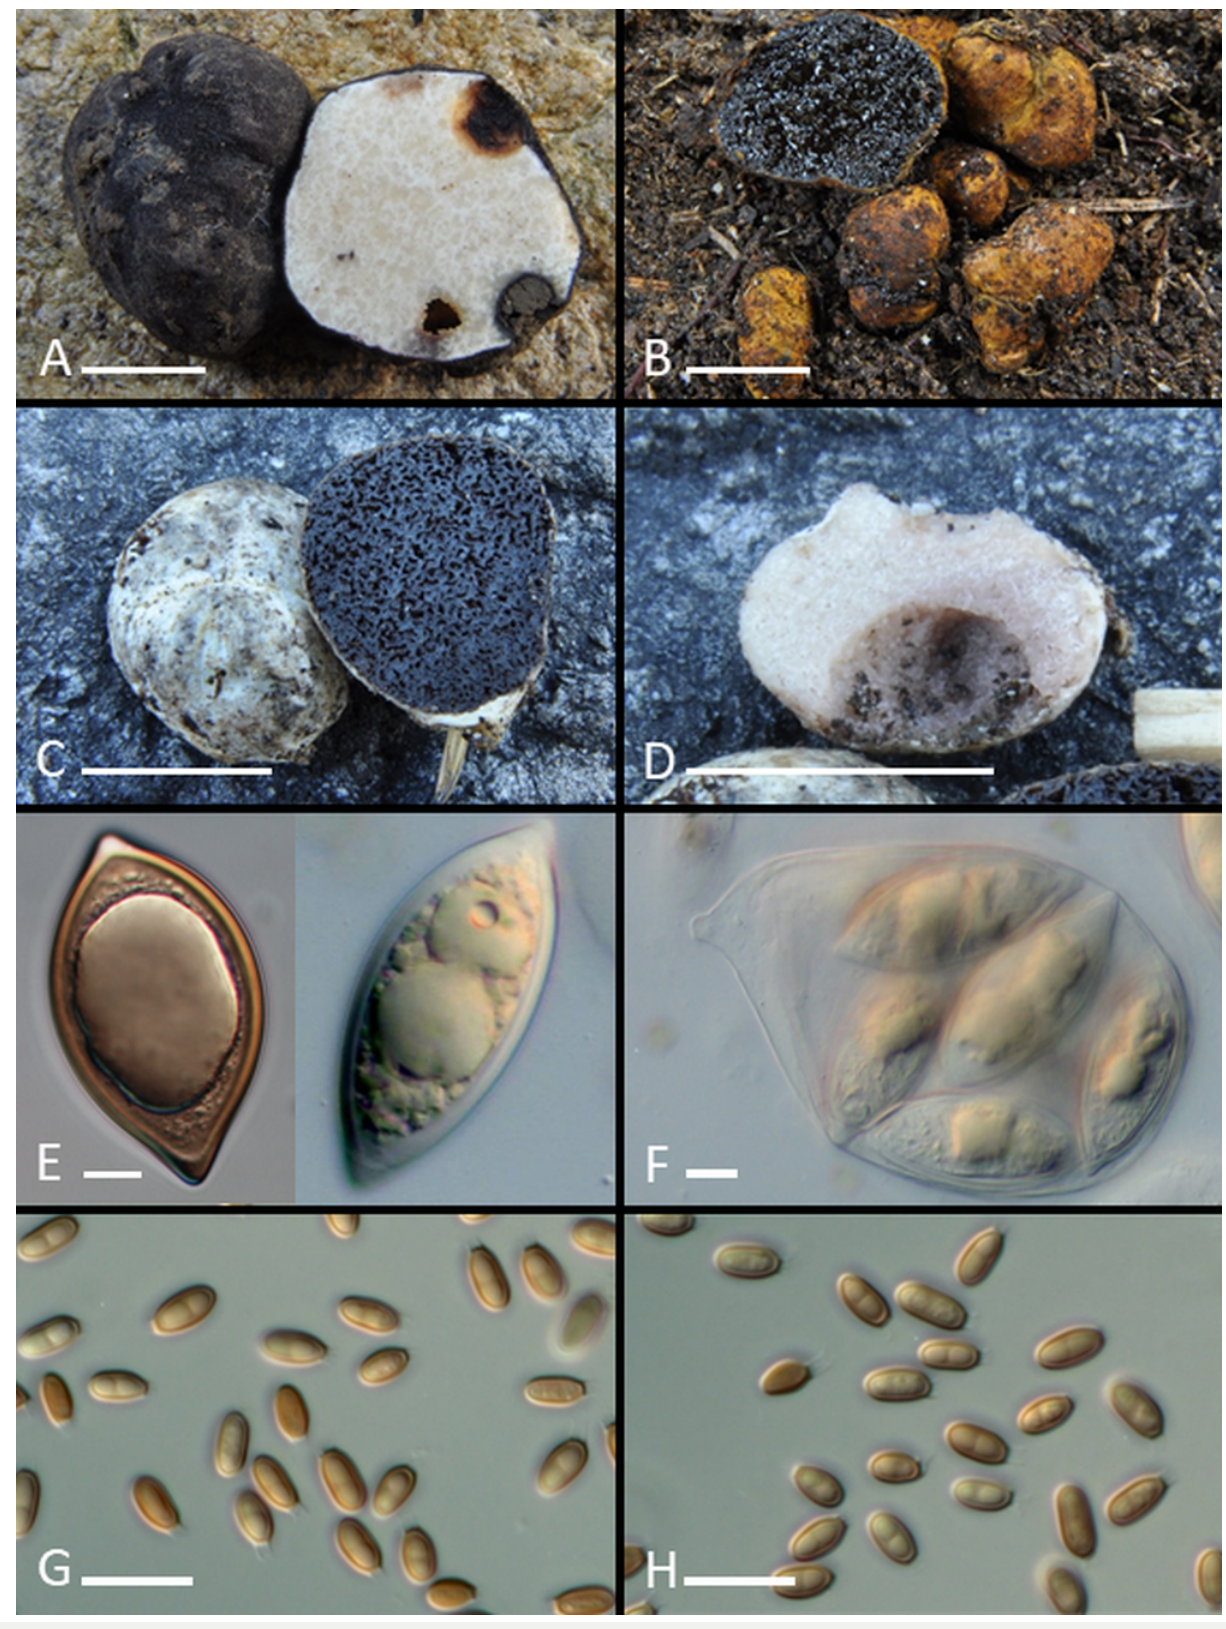
F igure 2 Sporocarps and spores of hypogeous fungi: ( A ) Sporocarp of Leucangium carthusianum ; ( B ) sporocarps of Melanogaster luteus ; ( C,D ) mature ( C ) and immature ( D ) sporocarps of Rhizopogon melanogastroides ; ( E ) spores of L. carthusianum ; left – spore from fresh specimen, right – spore from dry specimen (8-years old); ( F ) ascus of L. carthusianum ; ( G,H ) spores of M. luteus . Scale: ( A–D ) 10 mm; ( E–H ) 10 µ m. Photo: ( A–D ) M. K.; ( E–H ) P. M. ( A ) KRA F-TPN/19-0357; ( B,G,H ) KRA F-TPN/19-0006; ( C,D ) KRA F-TPN/19-0056; ( E,F ) KRA F-2012-38.